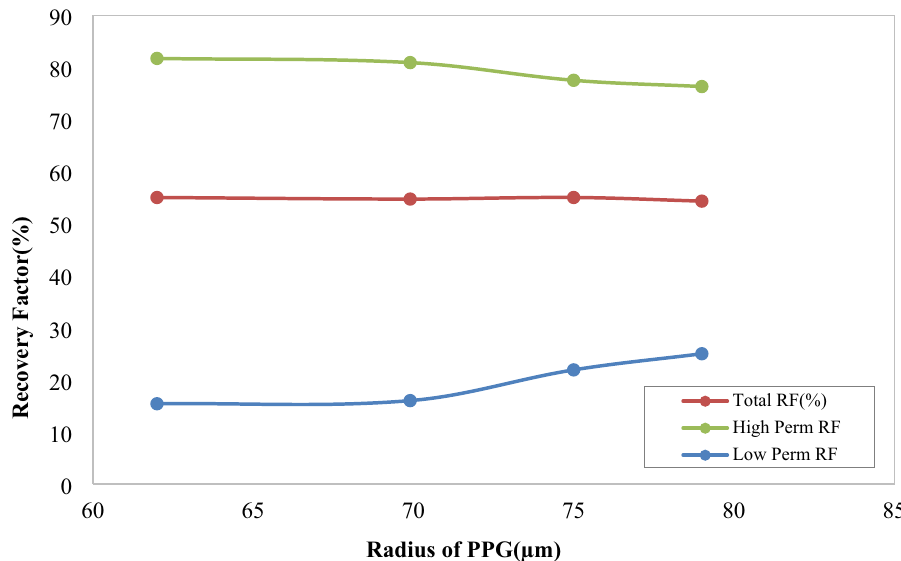
Figure 15. Effect of hydrogel size on oil recovery factor in high and low permeability regions and the whole micromodel.